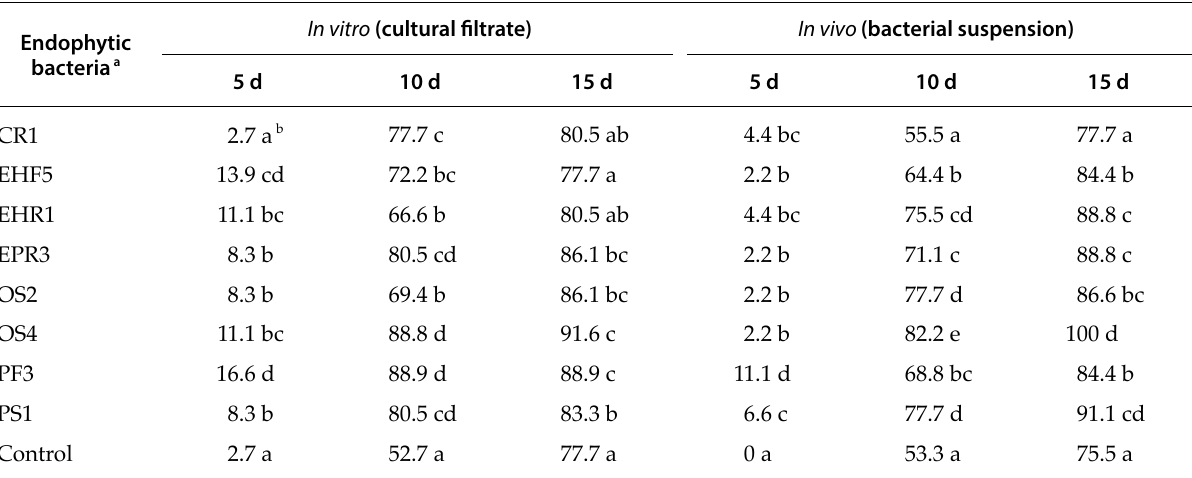
Table 4. Mean percentage of germinated seeds at 5, 10 and 15 d after bacterization with endophytic strains in vitro and in vivo . In vitro (cultural filtrate) Endophytic bacteria a